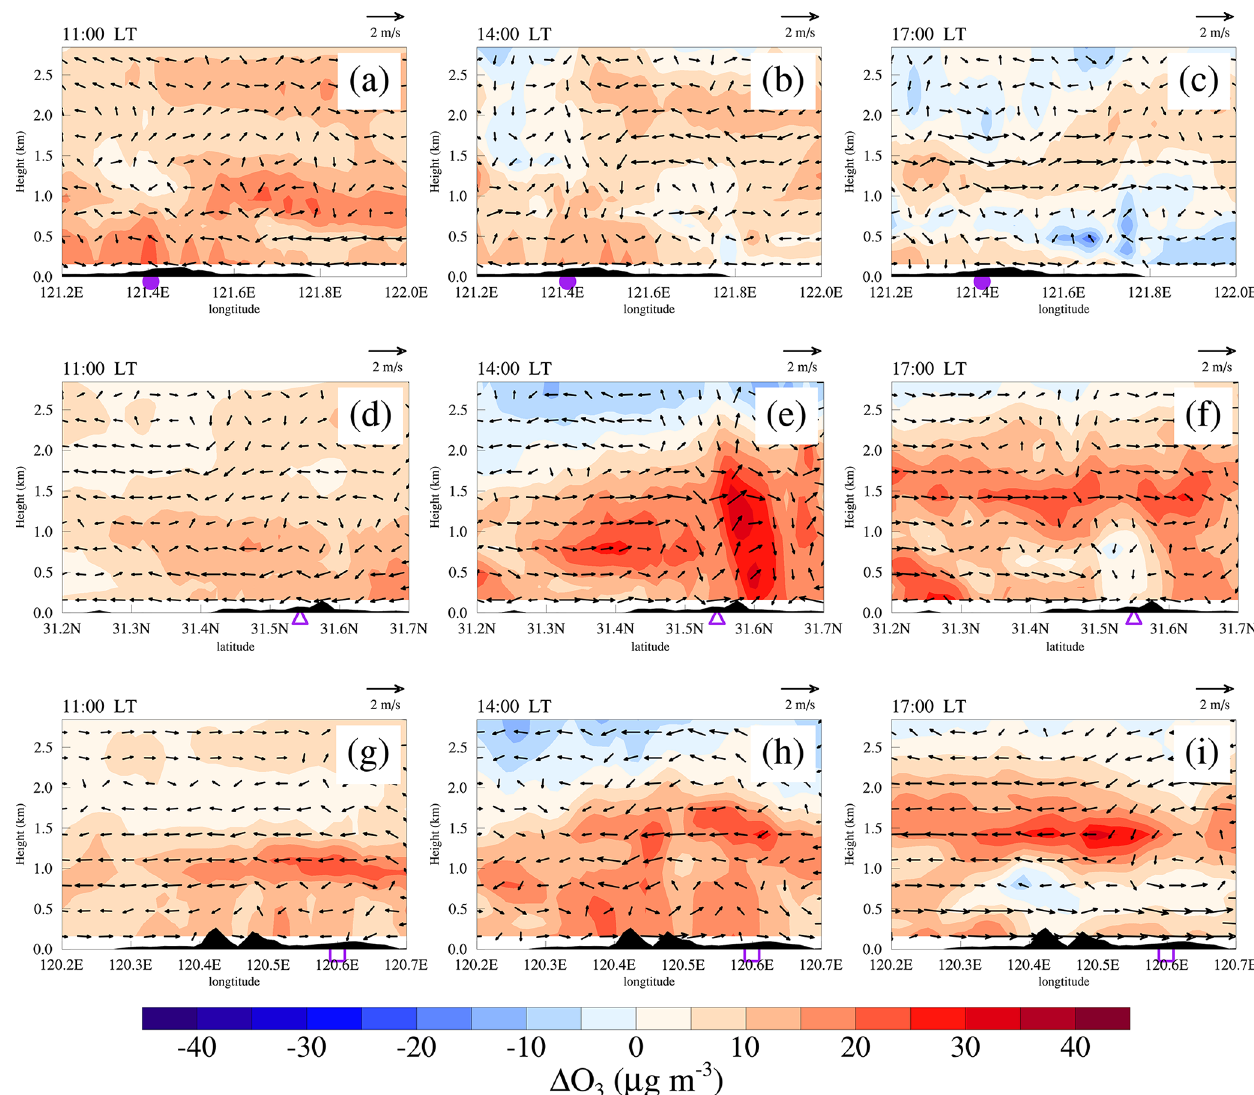
Figure 11. Same as Fig. 9 but for the differences between MODIS_noAH and USGS_noAH (MODIS_noAH − USGS_noAH).